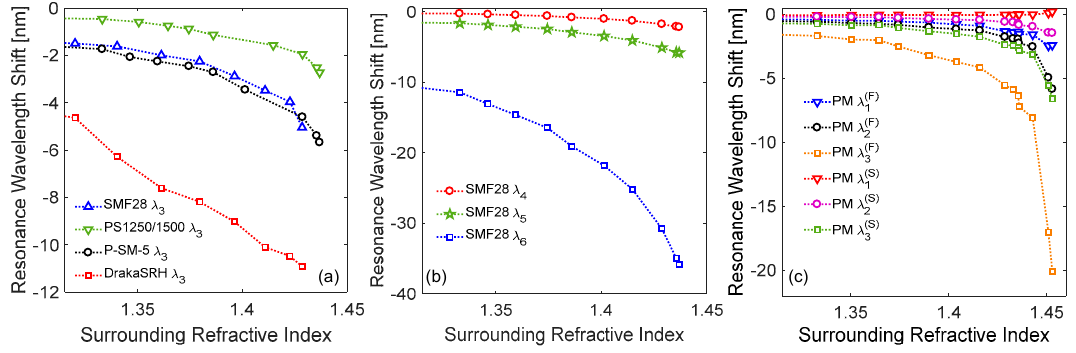
Figure 8. Resonance wavelength shifts towards surrounding refractive index (SRI) for LPGs in: ( a ) solid silica fibers with different dopants; ( b ) standard fiber with low period; ( c ) polarization-maintaining Panda fiber.